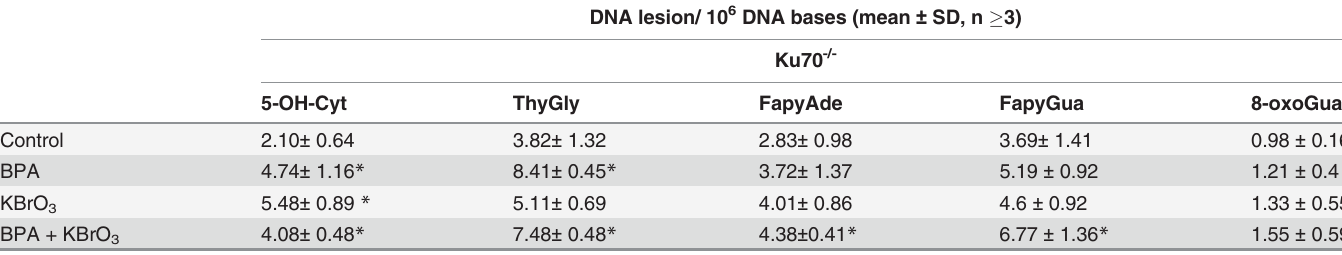
Table 1. Levels of selected modi fi ed DNA bases in genomic DNA in Ku70-/-.